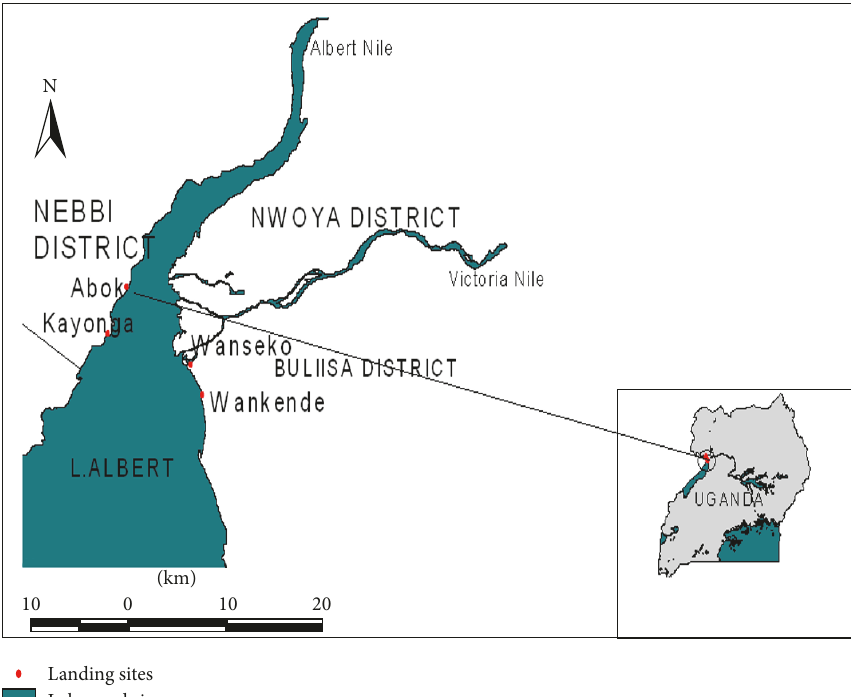
Figure 1: Map showing the study